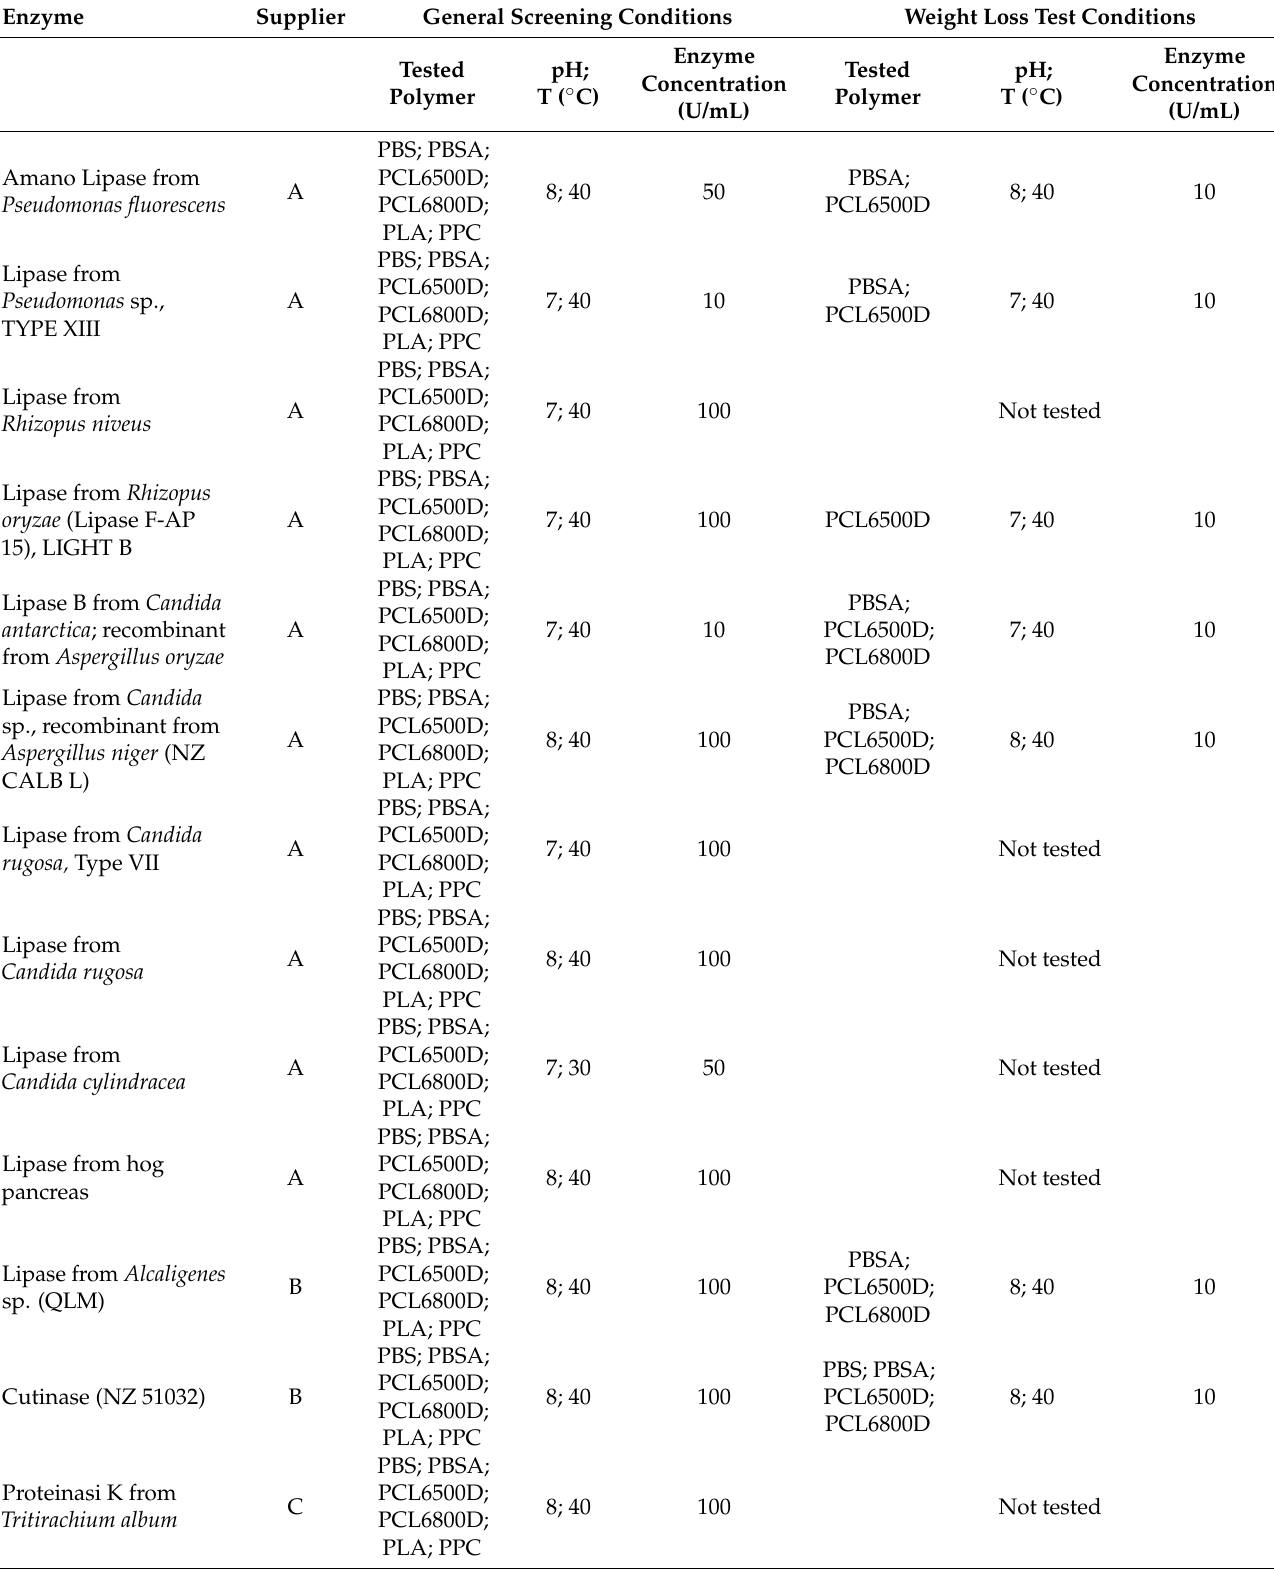
Table 1. Hydrolytic enzymes with indication of the supplier: A, Sigma-Aldrich; B, ChiralVision; C, J&K, and conditions used in the preliminary screening and weight loss test, such as polymers tested, pH, temperature ( ◦ C) and enzyme concentration